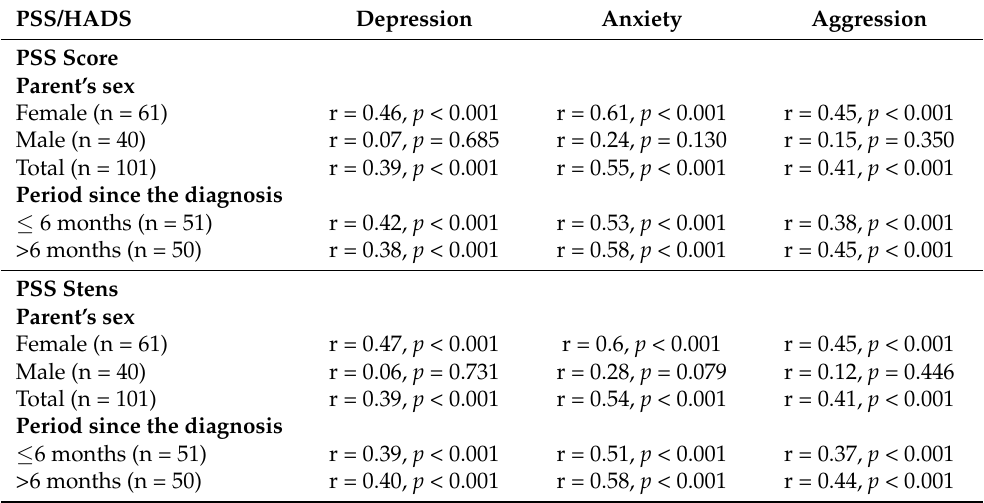
Table 5. Correlation between the level of stress and the level of depression, anxiety and aggression by parents’ sex and period since the